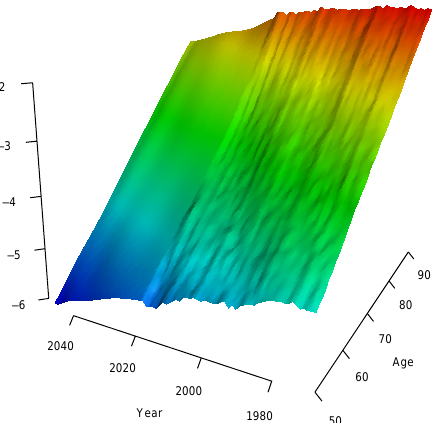
Figure 3. Logarithm of crude death rates from year 1970 to 2017 and logarithm of extrapolated death rates from 2018 to